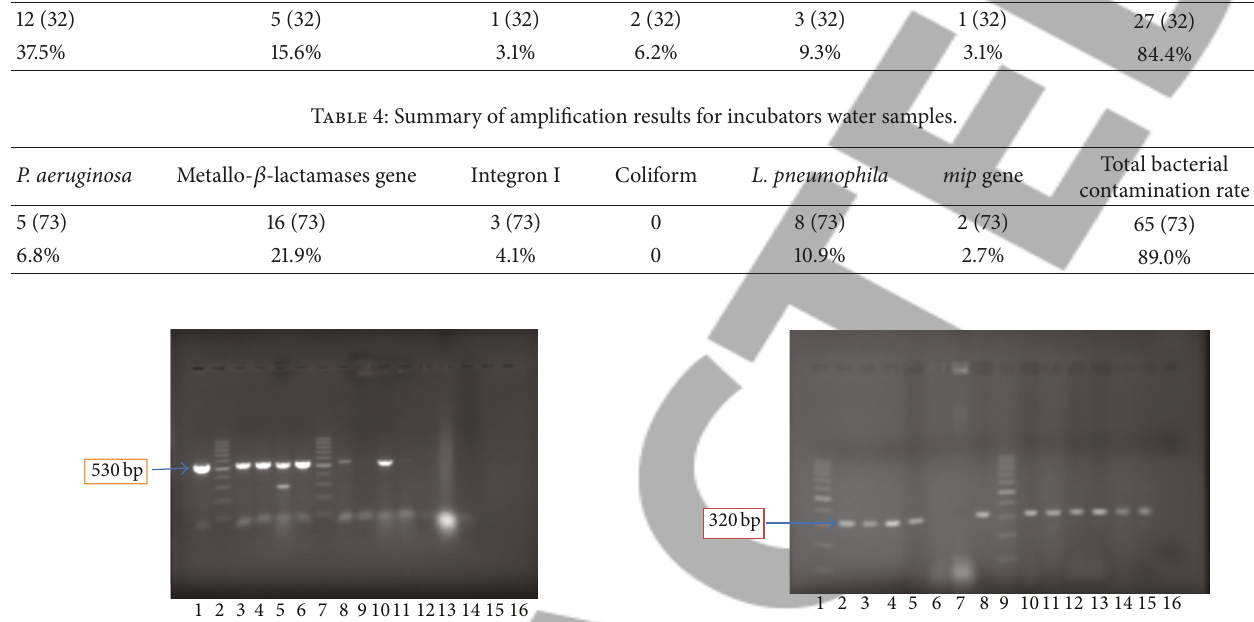
Figure 4: Results of PCR with universal primer for bacterial 16S rRNAgenefor13incubatorsamples.Line2ispositivecontrol( E.coli type strain ATCC 44338 ). Lines 1 and 9 are ladders (100–1000bp). Lines 3, 4, 5, 8, 10, 11, 12, 13, 14, and 15 are positive samples. Lines 6, 7, and 13 are negative samples, and line 16 is negative control